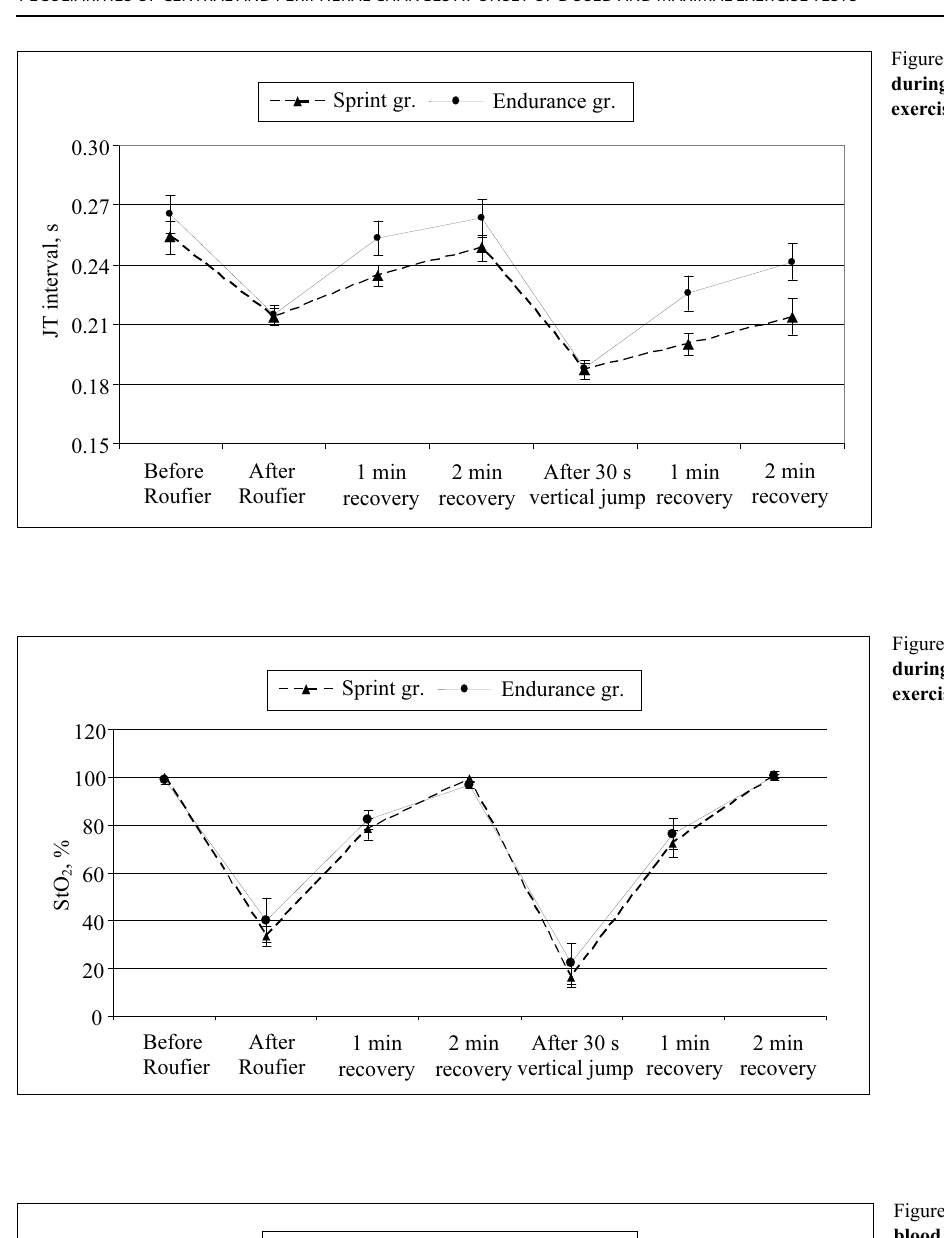
Figure 4. Dynamics of arterial blood flow during dosed